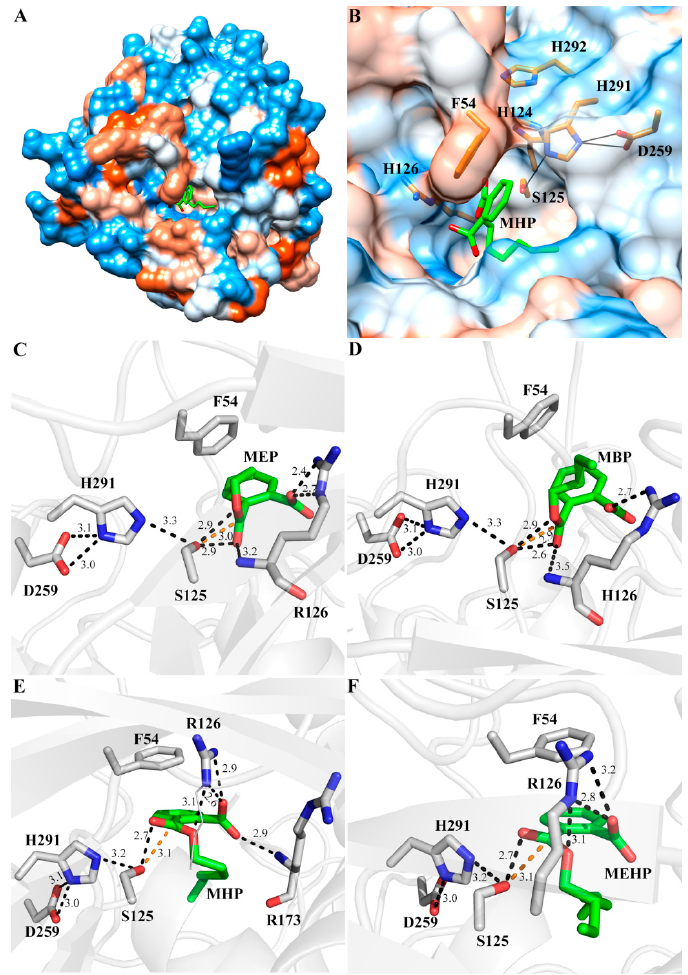
Figure 6. The interaction analysis of MphG1 and MAPs. ( A ) The overall structure of MphG1 binding mono-n-hexyl phthalate (MHP). The hydrophilic regions were displayed in blue and the hydrophobic regions in red. The molecule MHP was shown as green sticks; ( B ) The enlargement of MHP-binding site in ( A ). Some putative key residues around MHP were shown as orange sticks; Detailed structure of MphG1 docking with monoethyl phthalate (MEP) ( C ), mono-n-butyl phthalate (MBP) ( D ), mono-n-hexyl phthalate (MHP) ( E ) and mono(2-ethylhexyl) phthalate (MEHP) ( F ). The MAPs were shown as green sticks, and the amino acids binding and catalyzing MAPs were shown as gray sticks. The distance of hydrogen bond between the residues and MAPs was shown as black dashed lines (Å), and the distance between O γ of S125 and carbon atom of ester bond of MAPs was shown as orange dashed lines